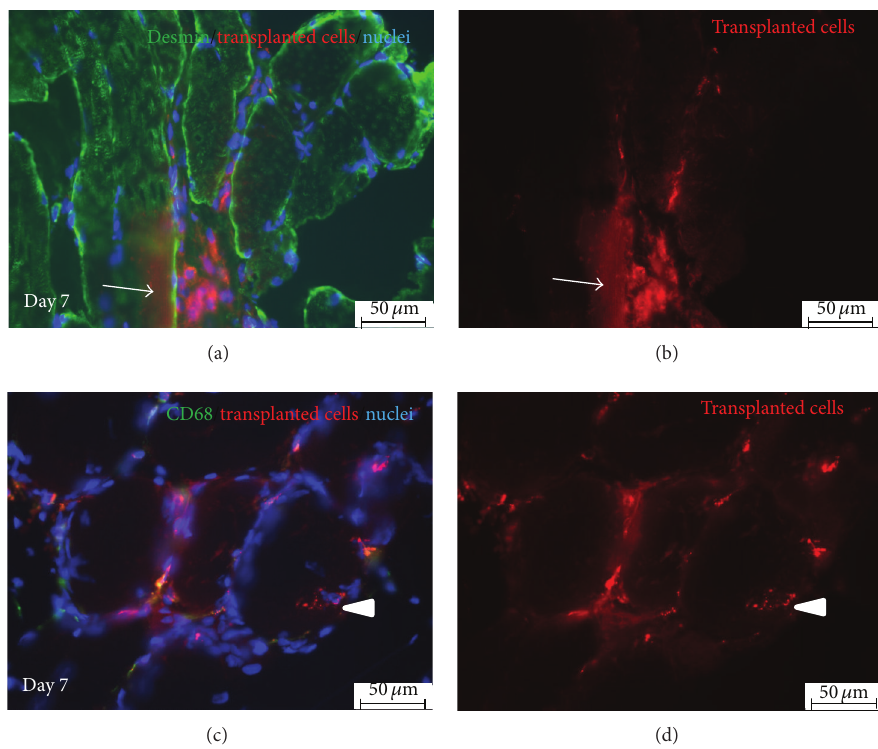
Figure 8: Immunohistochemical staining of samples collected 7 days after autologous MDCs injection. (a and b) PKH26 positive cells (red) can be recognized between and within muscle fibers (arrow), desmin stained with Alexa 488 (green); (c and d) PKH26 positive cells (red) can be recognized in the central position of muscle fiber (arrowhead) indicating the ability to contribute muscle regeneration. Few macrophages (CD68 stained with Alexa 488 (green)) are still present in the site of transplantation. Scale bars: 50 𝜇